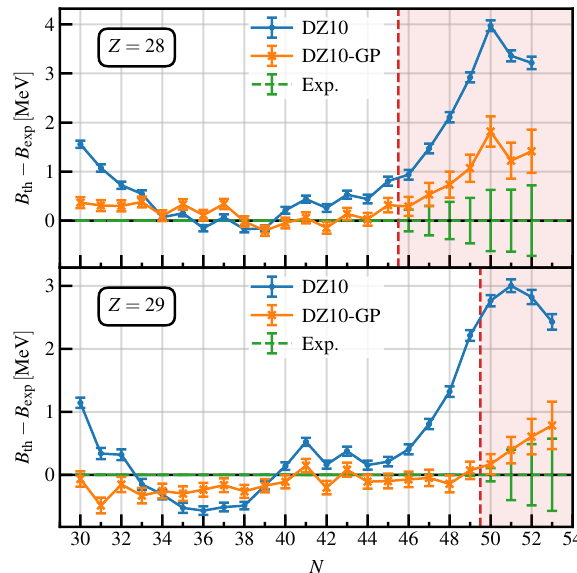
Figure 8. Residuals for the DZ10 and DZ10-GP models, for the Z = 28 and Z = 29 isotopic chains. The vertical dashed lines represent the transition from nuclei used for training to nuclei for which predictions are made. See text for